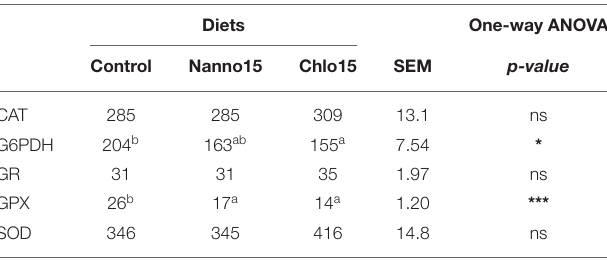
TABLE 3 | Specific activities of glucose-6-phosphate dehydrogenase (G6PDH), glutathione peroxidase (GPX), glutathione reductase (GR) (mU/mg protein),